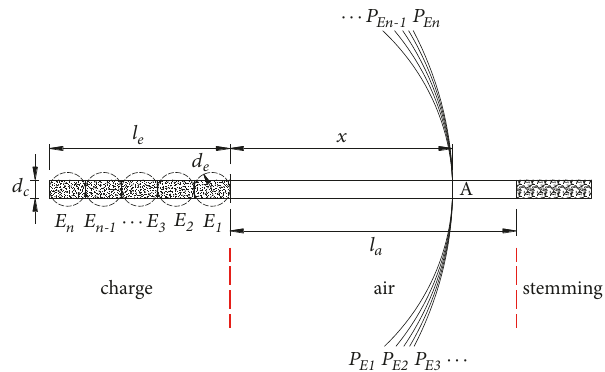
Figure 2: Initial shock pressure of borehole wall with upper air- decked